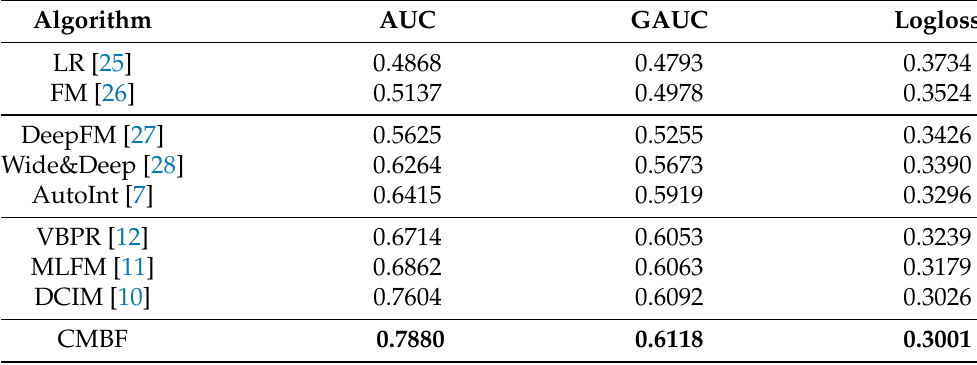
Table 5. Comparison of different algorithms on the Amazon dataset. The results in bold represent the best